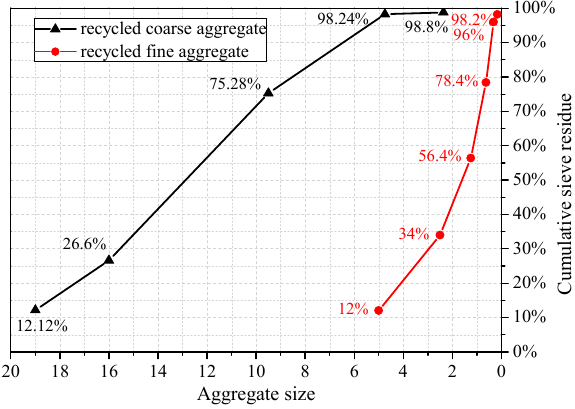
Figure 3. Particle size distribution of recycled coarse and fine aggregates.